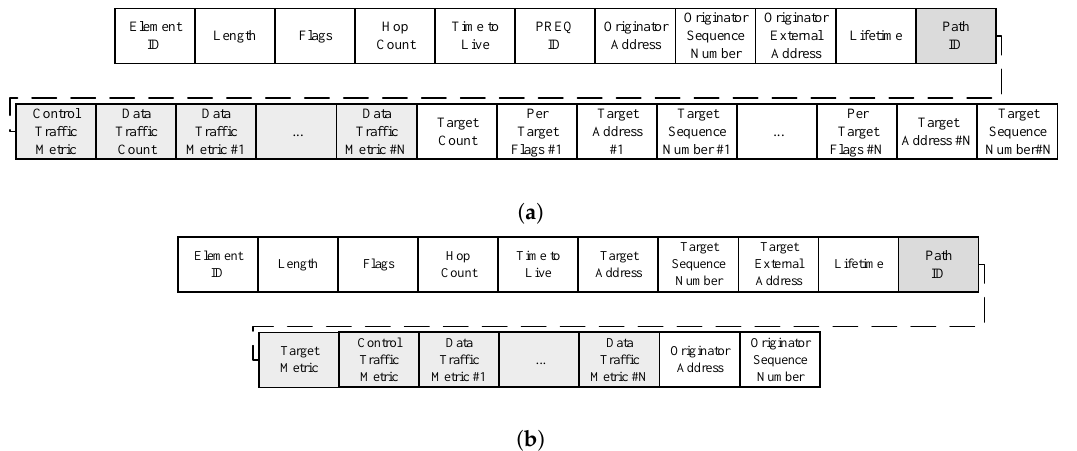
Figure 4. Path request and path reply modifications. ( a ) Path request. ( b ) Path reply.